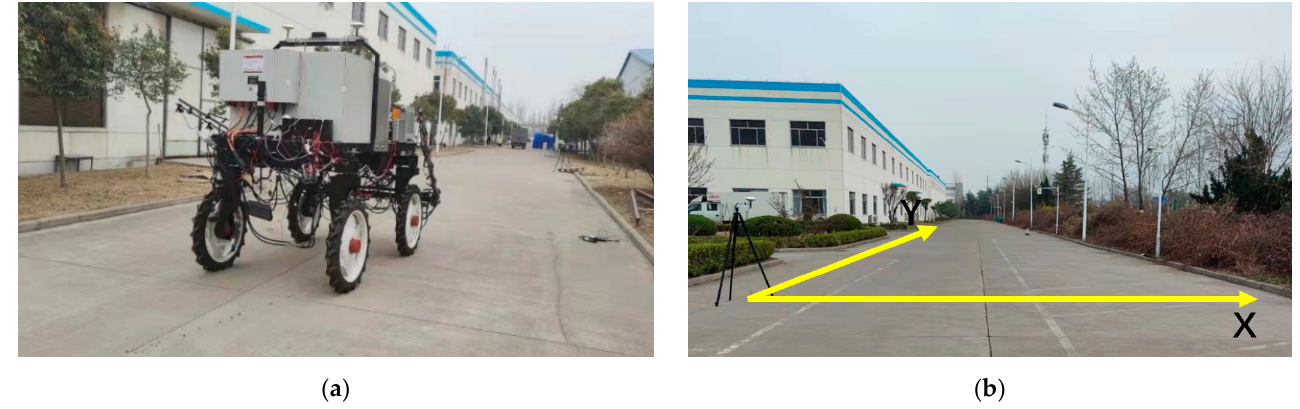
Figure 18. Linear path tracking test site. ( a ) Linear tracking test; ( b ) Coordinate system diagram.